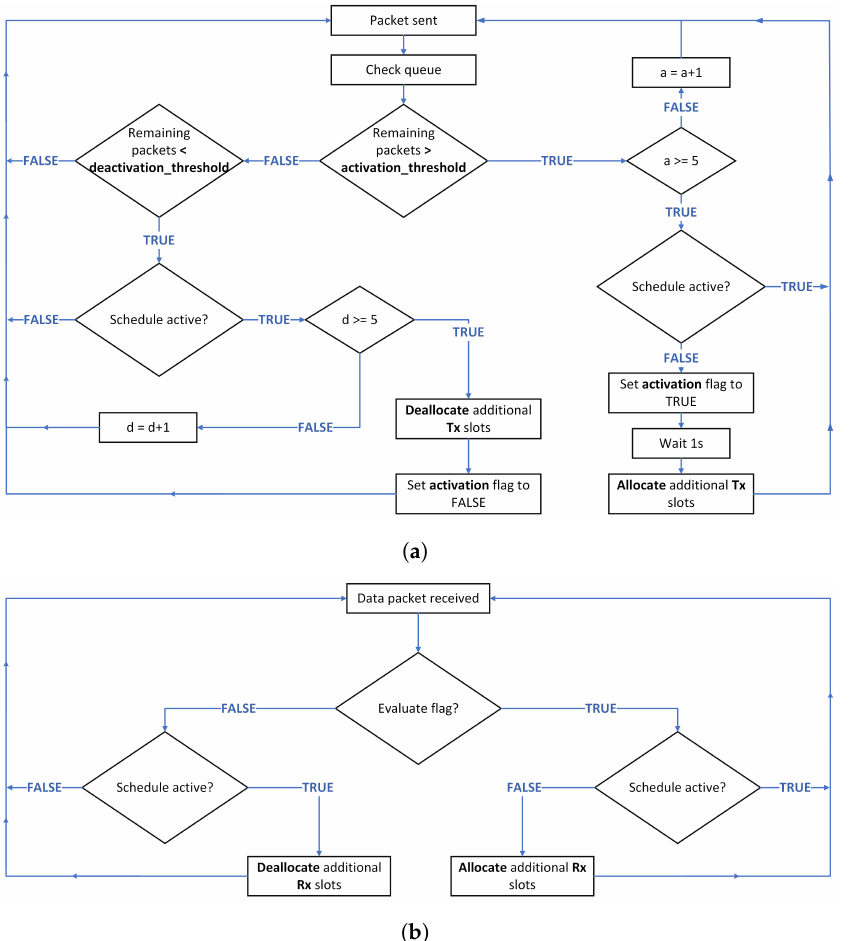
Figure 7. Summary of the allocation and deallocation phases for the root and its children. ( a ) The algorithm for allocating and deallocating Tx slots for the root’s children. ( b ) The algorithm for allocating and deallocating Rx slots for the